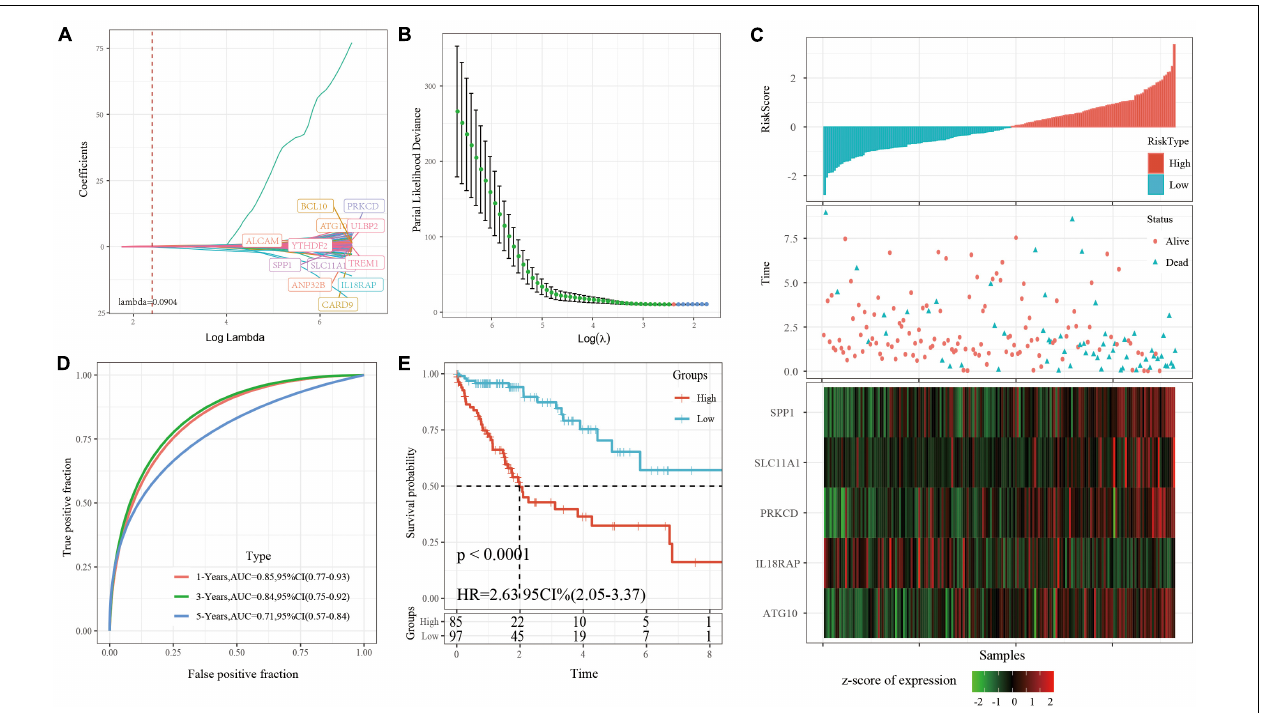
FIGURE 3 | (A) For the changing trajectory of each independent variable, the horizontal axis represents the log value of the independent variable lambda, and the vertical axis represents the coefficient of the independent variable. (B) The confidence interval under each lambda. (C) RiskScore, survival time, survival status, and 5-gene expression in TCGA training set. (D) ROC curve and AUC of 5-gene signature classification. (E) The KM survival curve distribution of 5-gene signature in training